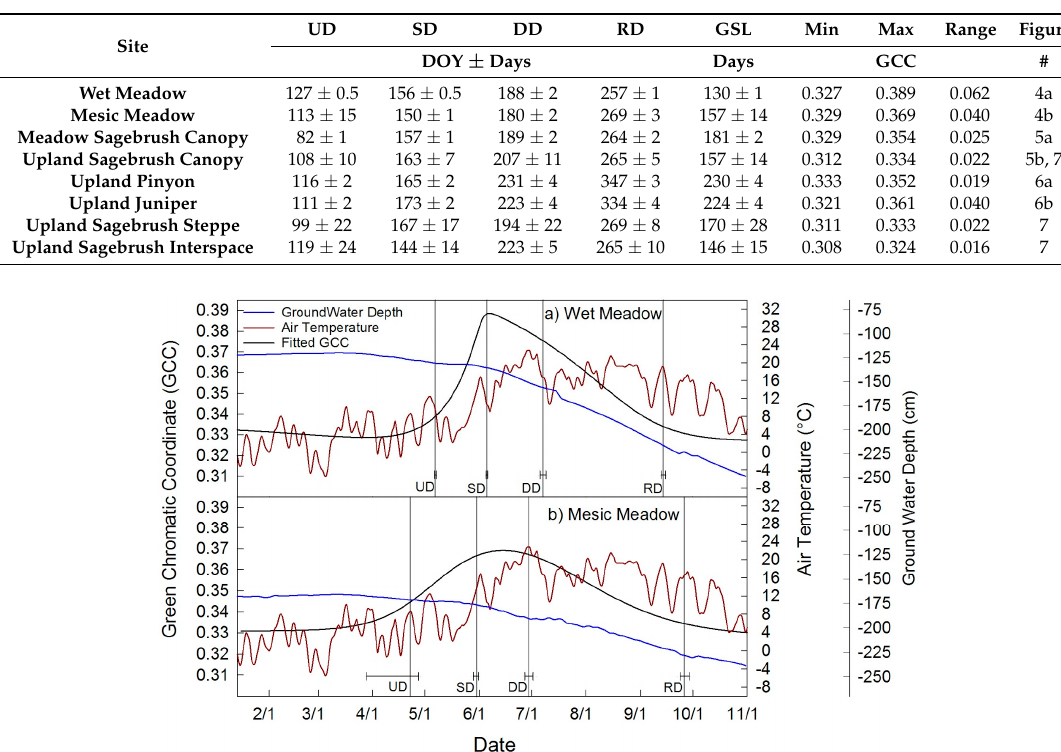
Figure 4. Seasonal course of GCC (black) and phenophase dates of ( a ) the wet meadow and ( b ) the mesic meadow, plotted with 3-day average daily air temperature (red) and average daily groundwater depth (blue).